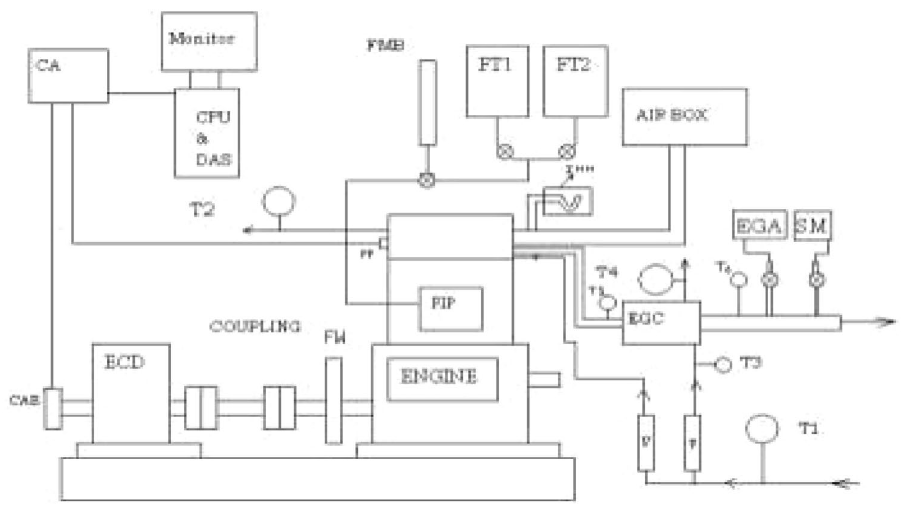
Figure 3. Schematic arrangement of D.I Engine